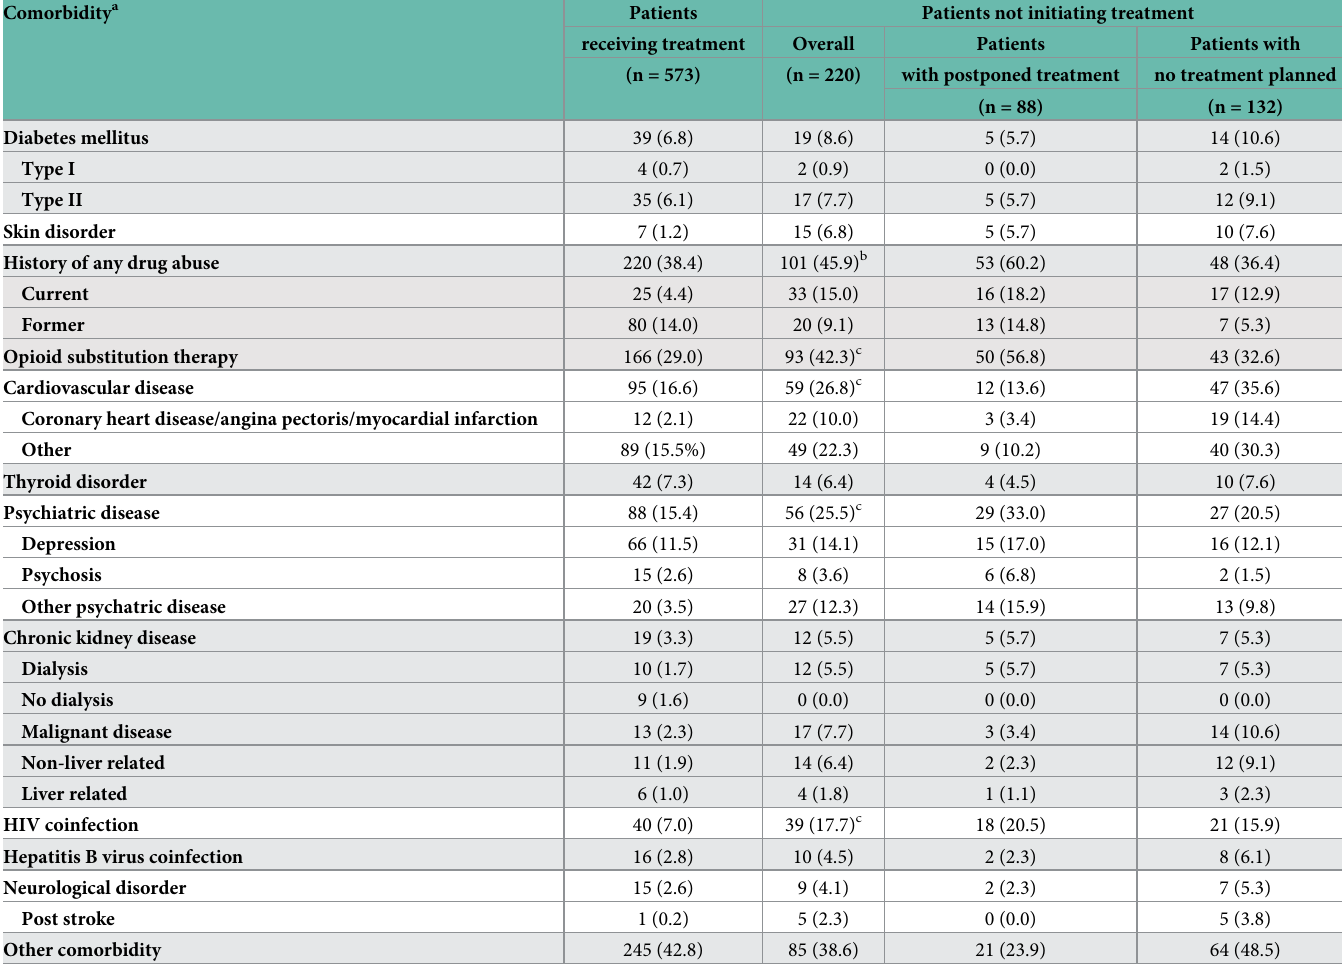
Table 2. Comorbidities in patients with CHC